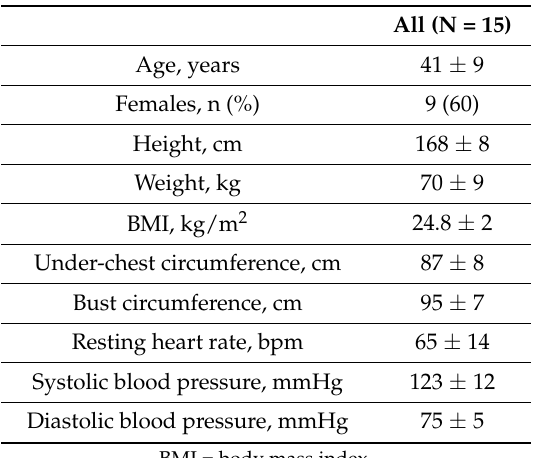
Table 1. Baseline characteristics of the study population.